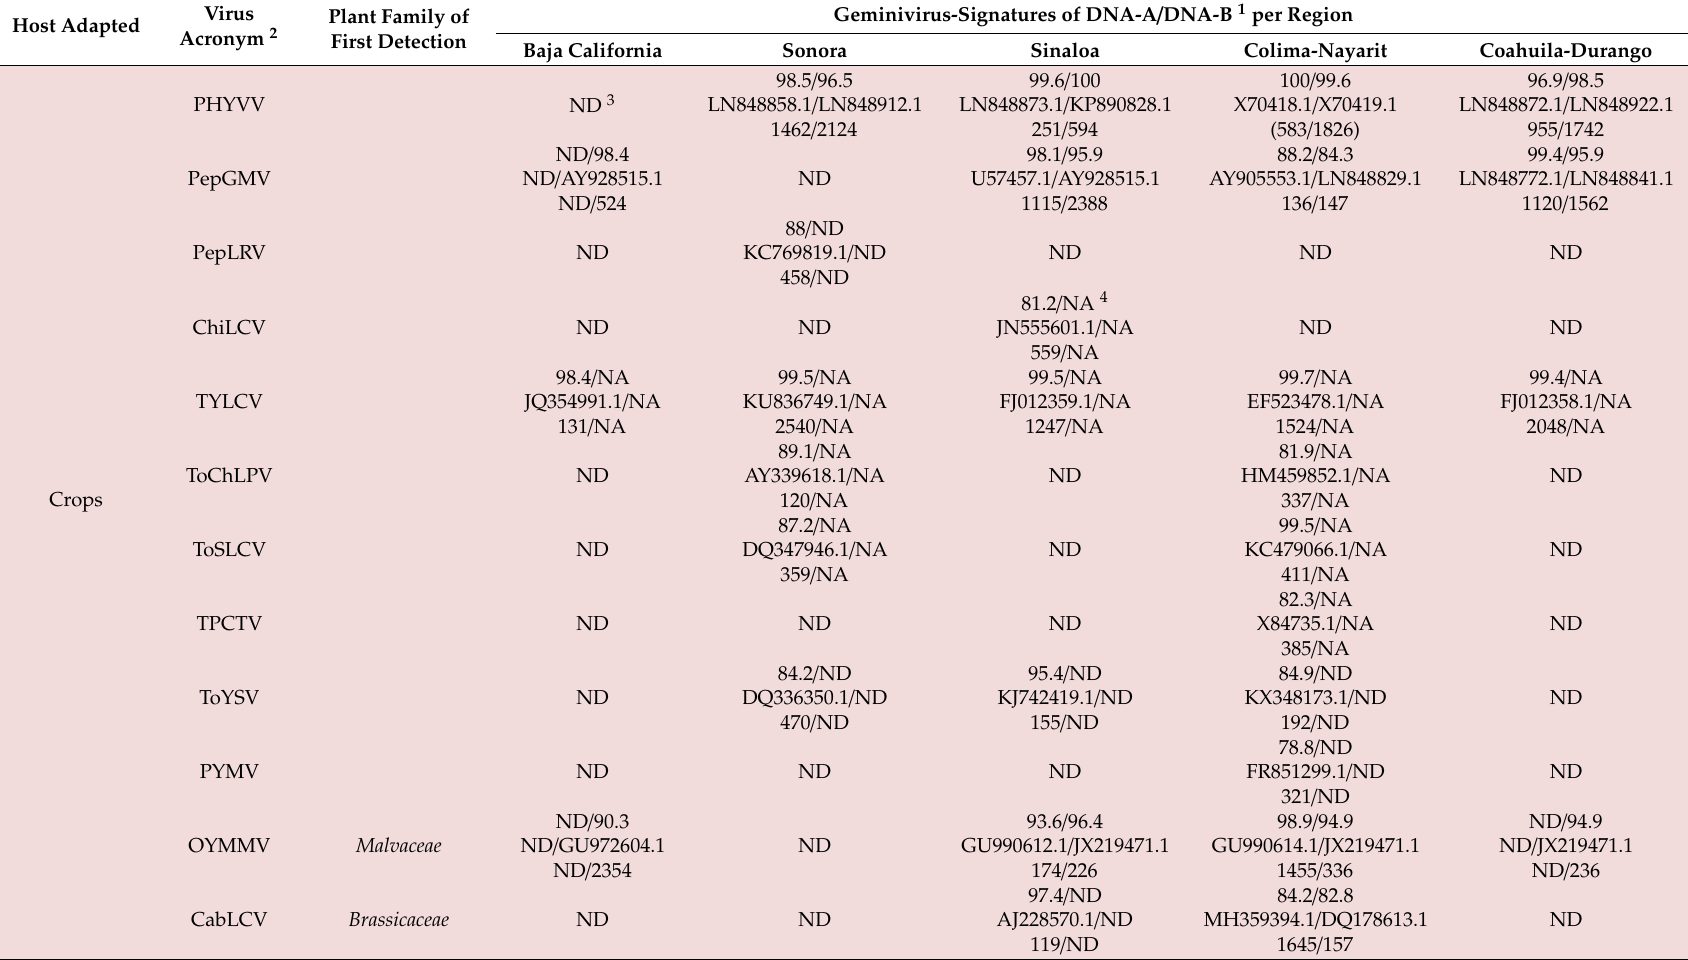
Table 3. Begomovirus signatures obtained by de novo assembly from the metagenomics study in plants collected in the agro-ecological interface from five regions in Northern-Pacific Mexico. Geminivirus-related reads for each NGS library were used for de novo assembly and generation of